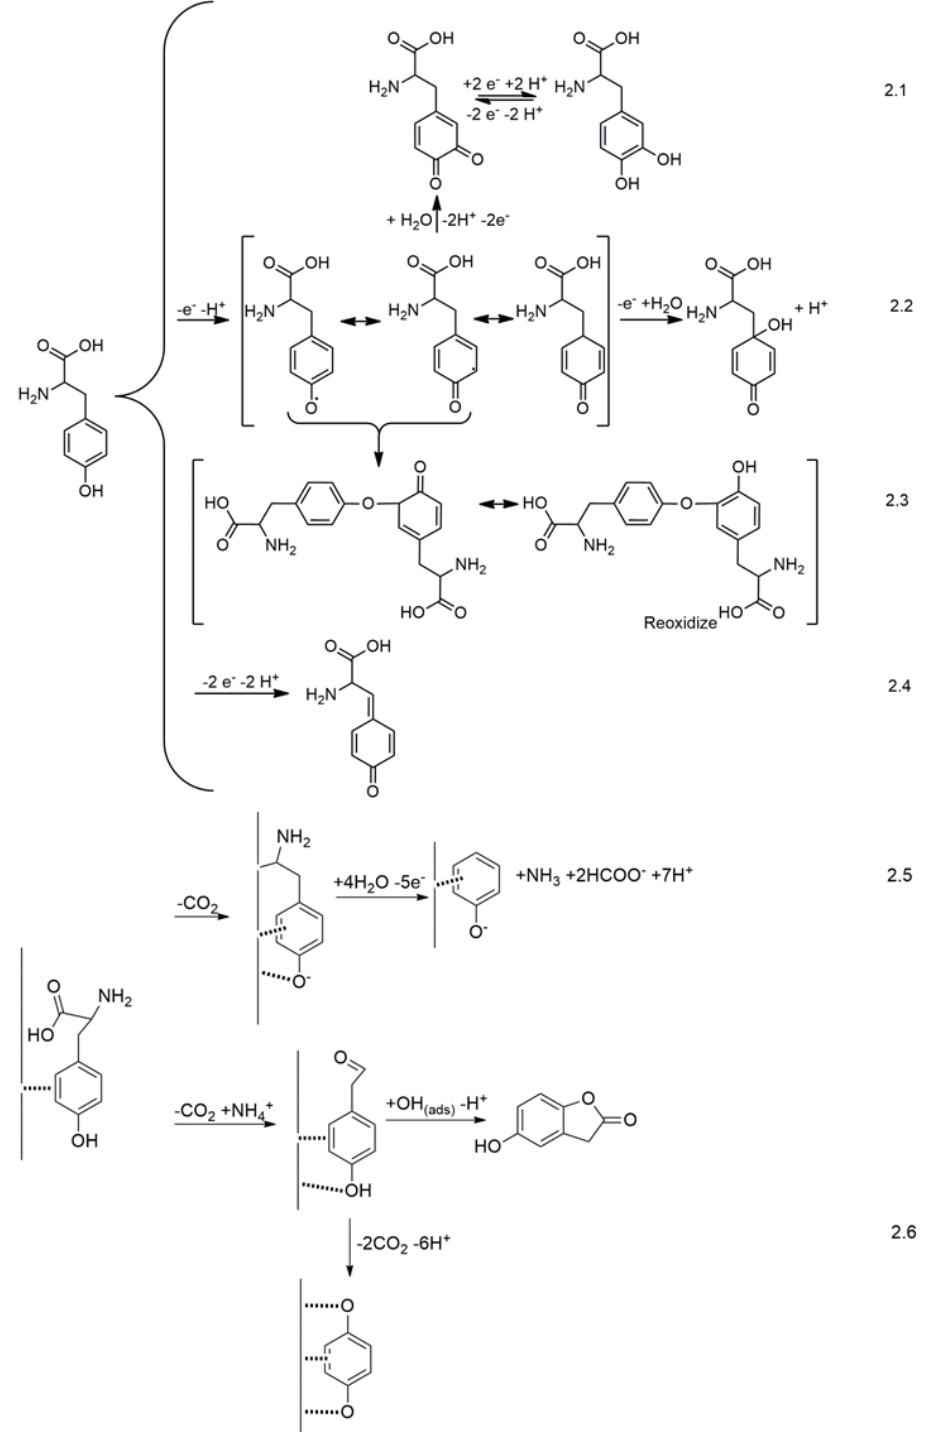
Figure 3 - Oxidation pathways proposed for L-Tyr in the literature by 2.1 (Enache and Oliveira-Brett 2011b), 2.2 and .3 (Malfoy and Reynaud 1980), 2.4 (Suprun et al. 2013), 2.5 (Ogura et al. 1999) and 2.5 (Zinola et al.